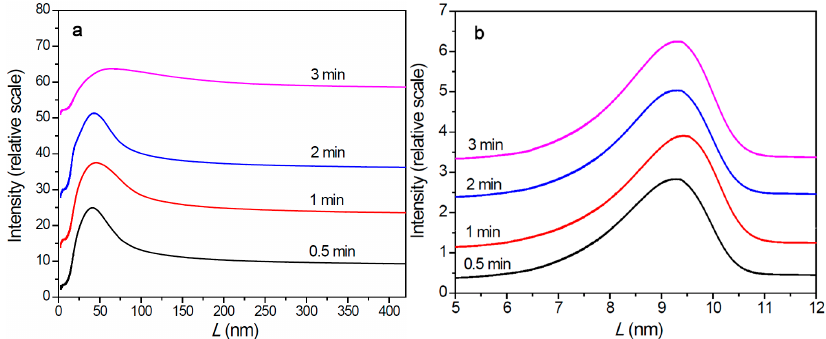
Figure 6. Lamellar thickness distribution of nascent polymer collected at different polymerization time. ( a ) Polyethylene and ( b ) polypropylene.